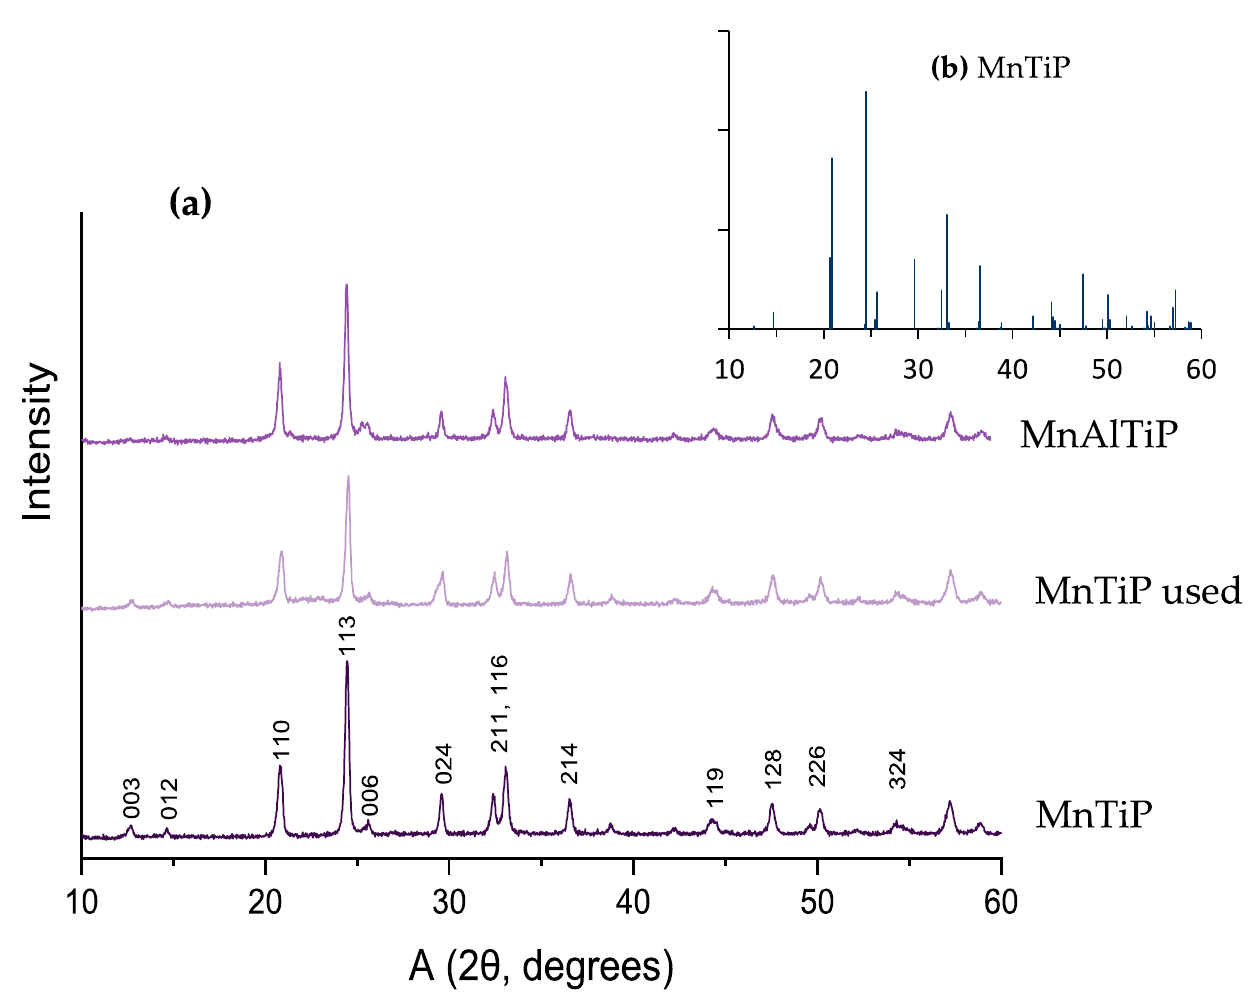
Figure 1. ( a ) XRD patterns of catalysts: Mn 0.5 Ti 2 (PO 4 ) 3 (MnTiP) initial, Mn 0.5 Ti 2 (PO 4 ) 3 used (MnTiP used), Mn 0.6 Al 0.2 Ti 1.8 (PO 4 ) 3 (MnAlTiP) initial; ( b ) XRD data for Mn 0.5 Ti 2 (PO 4 ) 3 (MnTiP) simulated basing on the structural data [27]. Table 1. Lattice parameters of the studied catalysts.